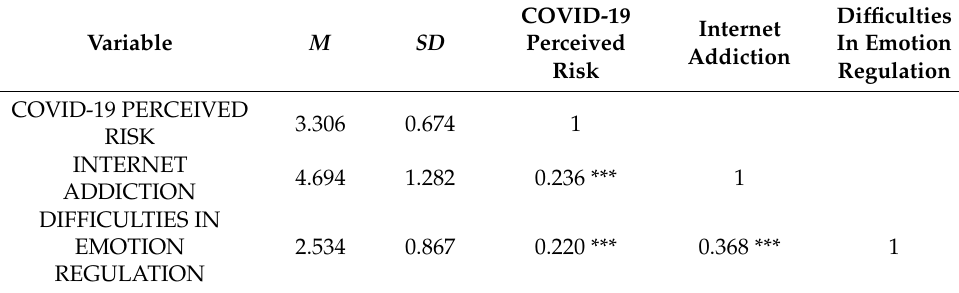
Table 5. Descriptive statistics and correlation analysis.